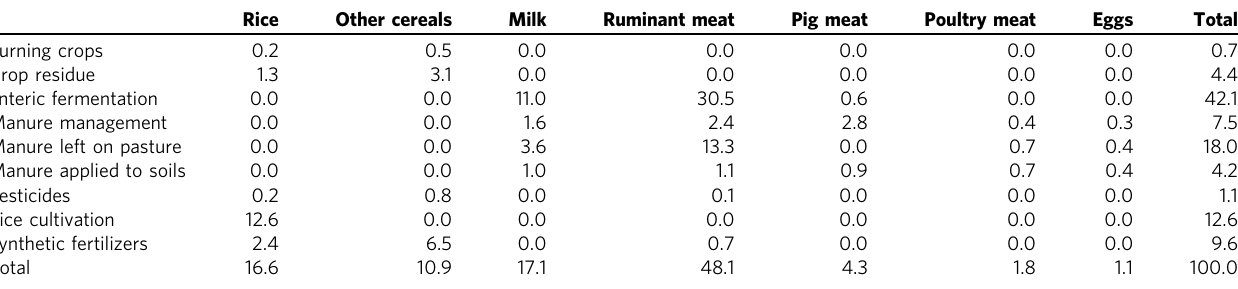
Source: authors ’ computation. Note: data in the table are global